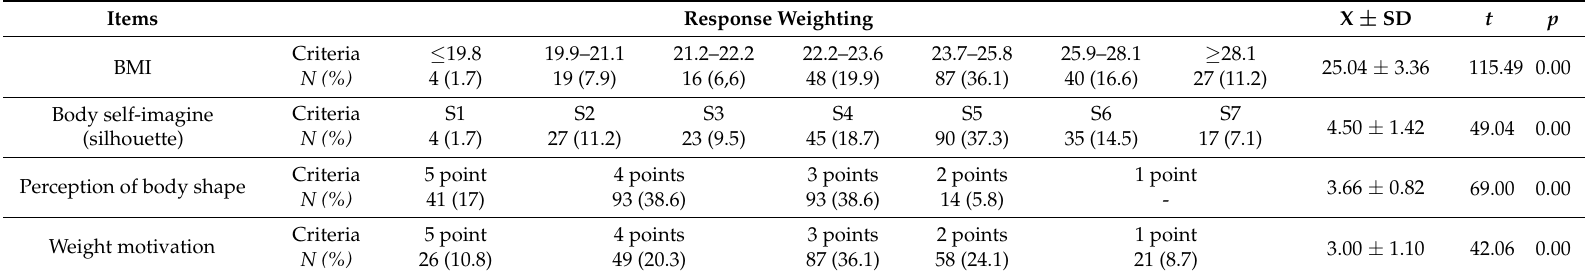
Table 3. The statistical analysis of data according to the evaluation of the body perception